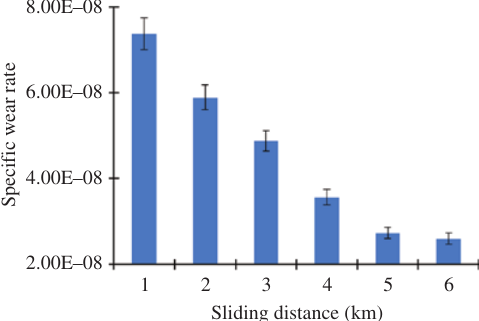
Figure 8: Specific wear rates of treated CNS filler composites (30%) with sliding